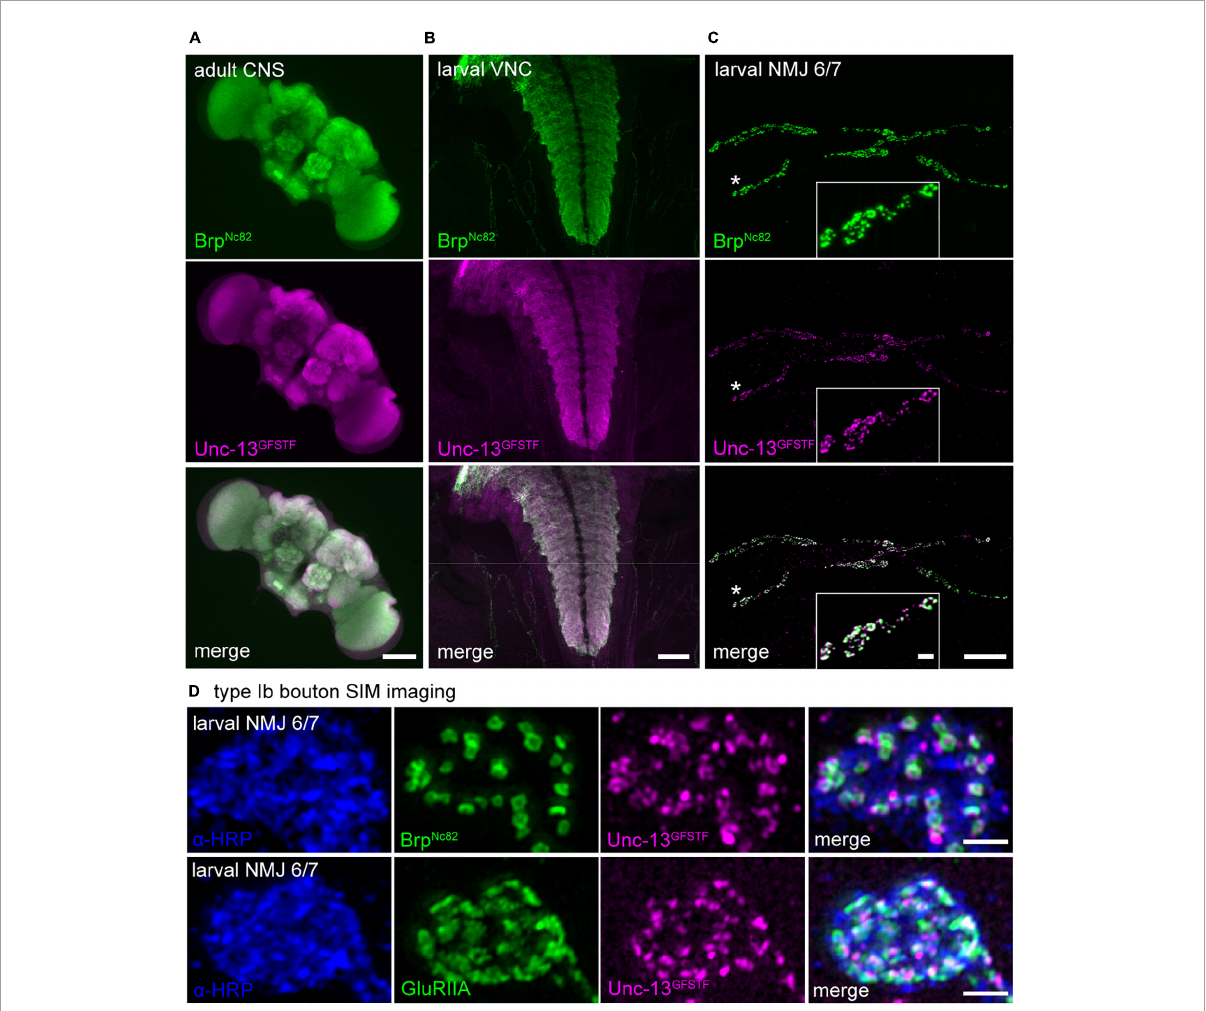
FIGURE2 Unc-13 GFSTF is expressed in the adult and larval central nervous system and at larval neuromuscular junctions (NMJs). (A) Adult central nervous system (CNS) stained with Brp Nc82 (green) and rabbit α -green fluorescent protein ( α -GFP) antibody to visualize Unc-13 GFSTF (magenta). (B) Larval ventral nerve cord (VNC) of a male 3rd instar Drosophila larva stained with the same antibodies as in (A) . (C) Co-expression of Brp Nc82 (green) and Unc-13 GFSTF (magenta) at a 3rd instar larval NMJ on abdominal muscles 6/7 in segment A3. (D) Structured illumination microscopy imaging of a type Ib bouton of a larval NMJ on abdominal muscles 6/7 shows pre- and postsynaptic co-localization of α -horseradish peroxidase ( α -HRP) (blue), Unc-13 GFSTF (magenta), and Brp Nc82 (green, upper panel) or GluRIIA receptor subunits (green, lower panel). Scale bars in (A) and (B) 100 µ m, in (C) 20 and 2 µ m (inset) and in (D) 1 µ